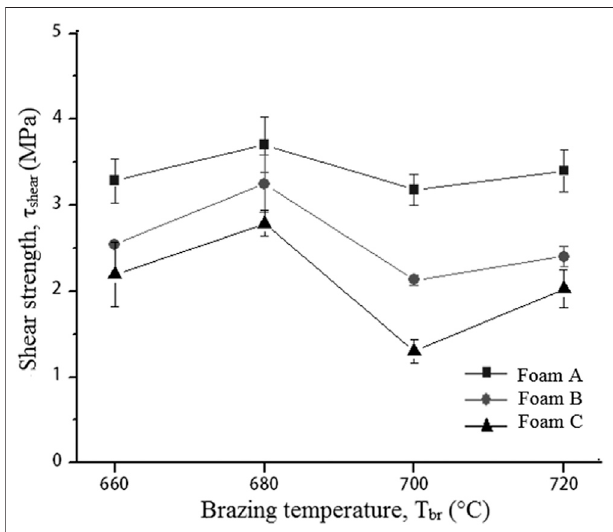
FIGURE4| ShearstrengthofbrazedCu/Cufoamusingamorphous fi ller with different Cu foam pore densities and brazing temperature.